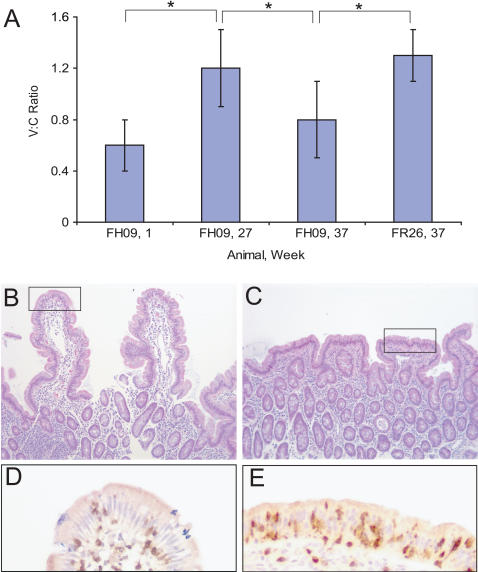
Gluten dependence of histological lesions in gluten-sensitive rhesus macaque FH09.(A) Morphometric analysis of villus height:crypt depth ratios from at least 4 different areas of distal duodenum in gluten-sensitive FH09 and control FR26 following dietary changes. Administration of a gluten-free diet increased the V:C ratio in FH09 at week 27 to a level that is statistically equivalent to that in FR26 (constant at all time points). Reintroduction of dietary gluten resulted in a drop in V:C ratio in FH09 (week 37) relative to that in FH09 on a gluten-free diet (week 27) and to that in FR26. *P<0.05. (B–C) H&E-stained duodenum at week 37 following 10 weeks of a gluten-containing diet. 100× magnification. (B) Control macaque FR26 exhibits normal villus architecture. (C) Gluten-sensitive macaque FH09 exhibits villus blunting. (D–E) Highlighted sections in B–C were examined by immunohistochemistry. 400× magnification. (D) Anti-CD3 staining in FR26 shows few CD3+ IELs (dark brown dots in epithelium). (E) Anti-CD3 staining in FH09 shows intraepithelial lymphocytosis.